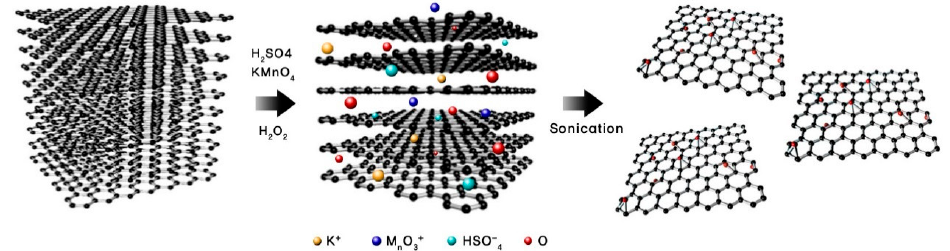
Figure 1. A proposed chemical reaction pathway for producing graphene oxide (reproduced with permission from [15]. Copyright Elsevier, 2016). permission from [15]. Copyright Elsevier,